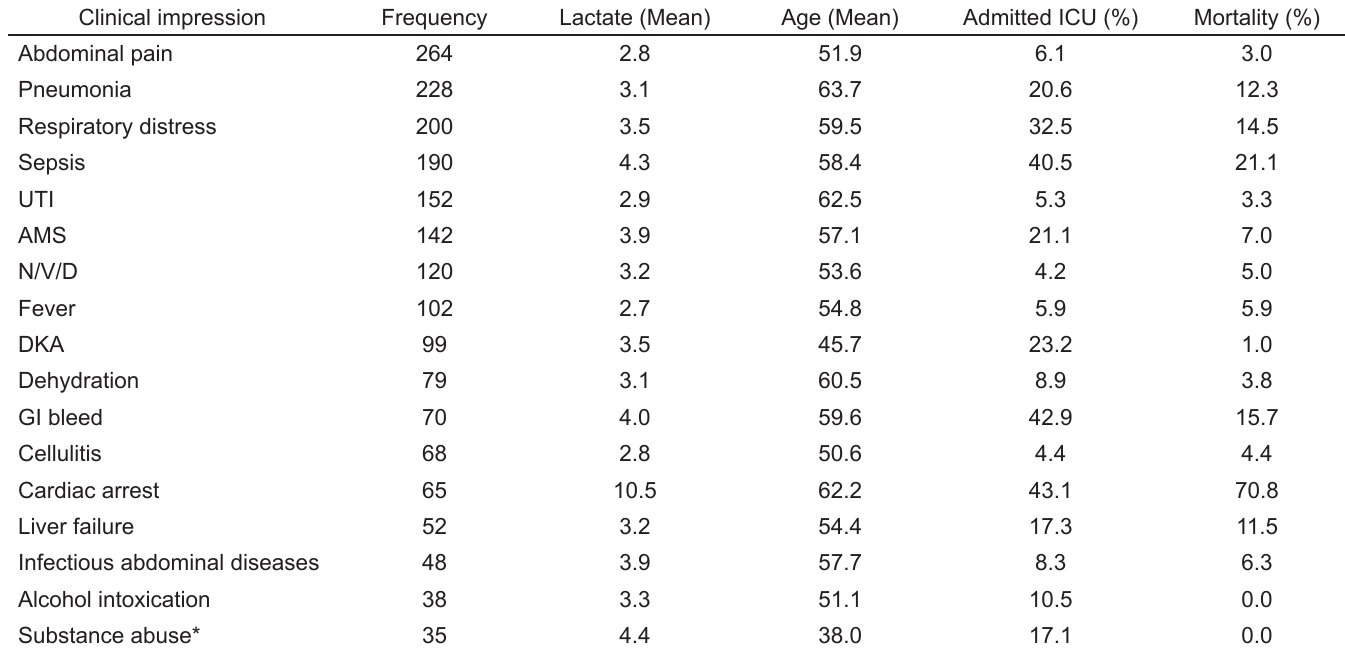
Table 3. Top clinical impressions of lactate >2 mmol/L by frequency.